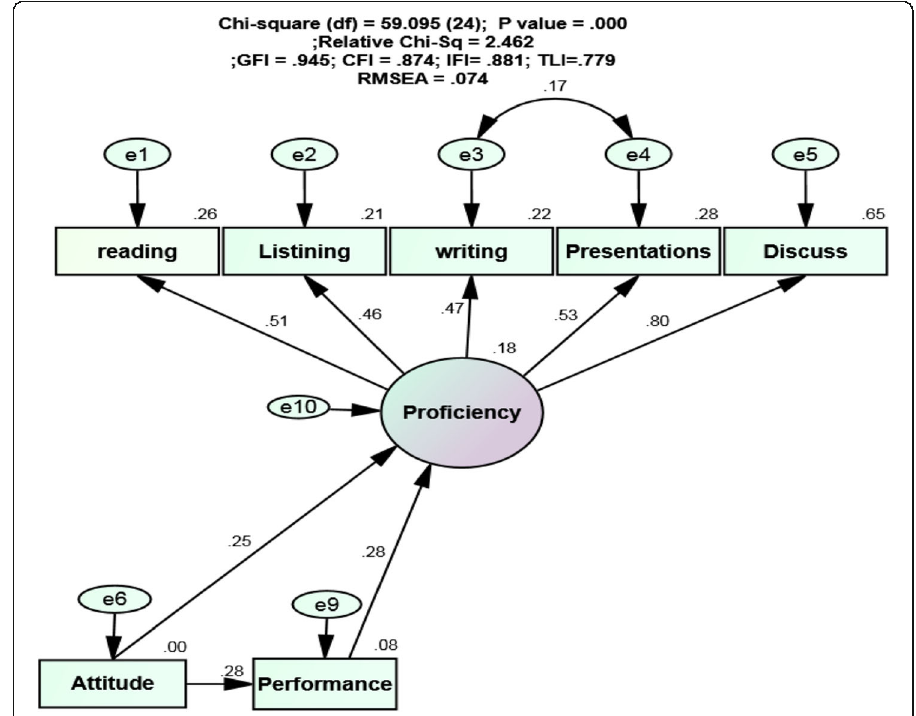
Fig. 4 Testing the effect of variables on performance for a group with high work experience based on standard values